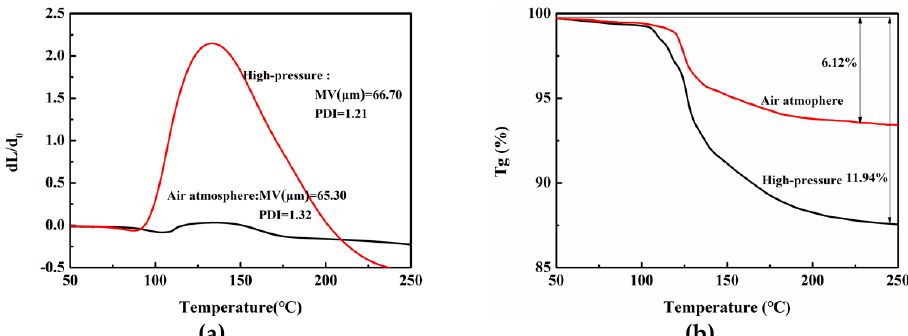
Figure 4. Thermal performance analysis of microspheres under high-pressure nitrogen and atmospheric air conditions: ( a ) Dilatometer (DIL) cures; ( b ) thermogravimetric (TG) cures.